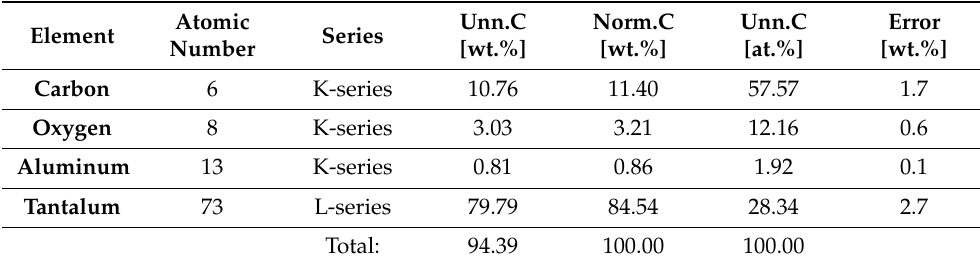
Table 4. EDX point analysis of the hexagonally-packed